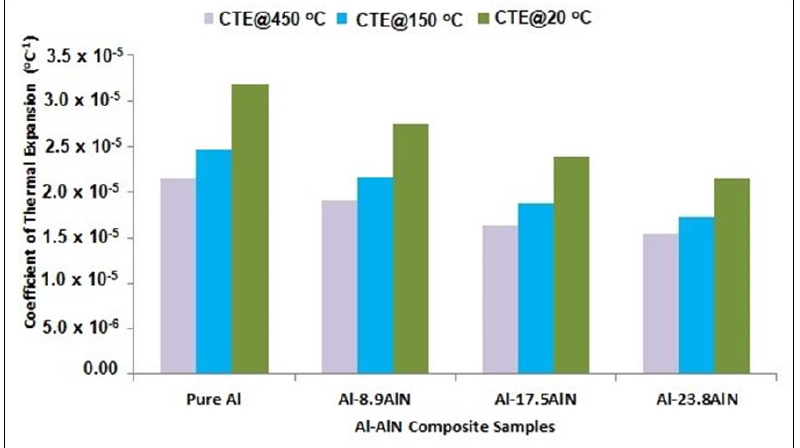
Figure 3. Profiles of volume fractions of AlN in Al against CTE at various temperatures, adapted from [61].